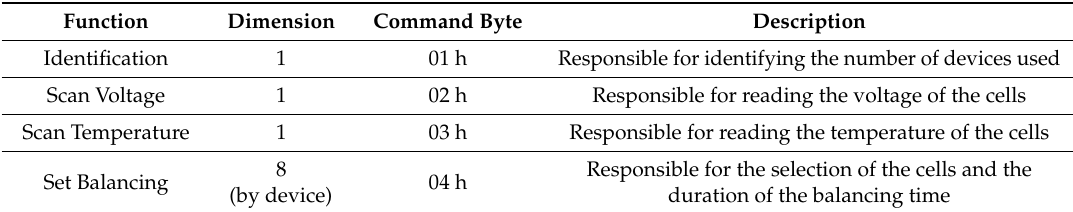
Table 2. Brief description of the functions implemented in the auxiliary control